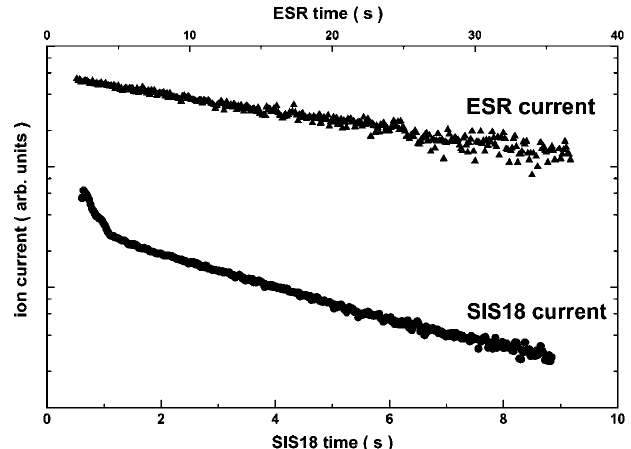
FIG. 1. Logarithmic plot of the U 28 þ ion current versus time at 10 MeV = u in the SIS18 synchrotron (lower curve) and the ESR storage ring (upper curve). The fast decay near the starting point of the SIS18 curve is due to injection losses and acceleration effects.